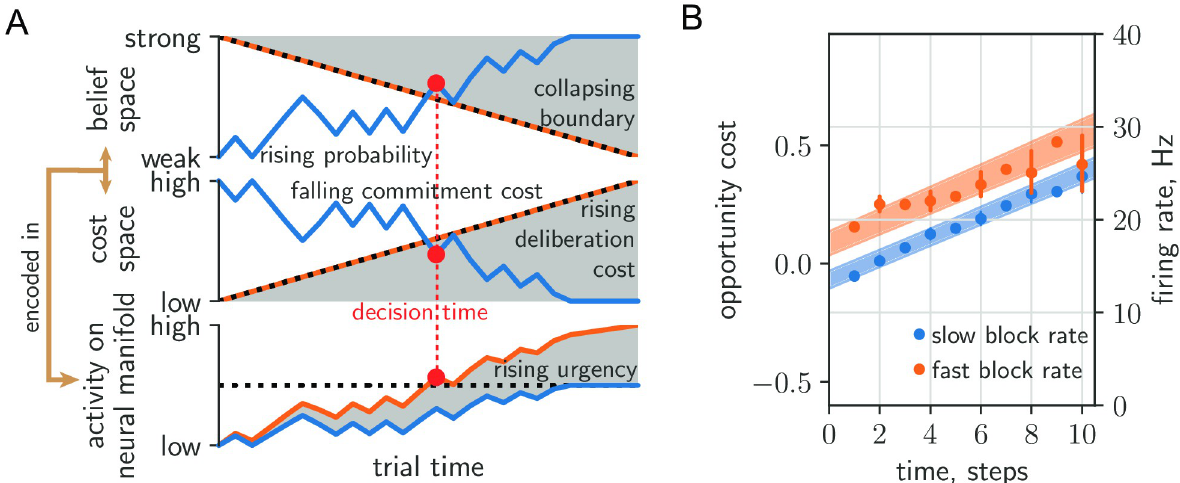
Fig 6. Comparing neural urgency and collapsing decision boundaries. (A) Top: Rising belief (blue) meets collapsing decision boundary (black dashed) in belief space. Middle: Falling commitment cost (blue) meets rising deliberation cost (black-dashed) in cost space. Bottom: Belief/ commitment cost is encoded (blue) into a low-dimensional neural manifold, with the addition of an urgency signal (orange) ( c.f . Figure 8 in [8]). The decision (red circle) is taken when the sum passes a fixed threshold (black-dashed). (B) Deliberation cost maps onto the urgency signal extracted from zero-evidence conditioned cell-averaged firing rate in PMd (200ms time